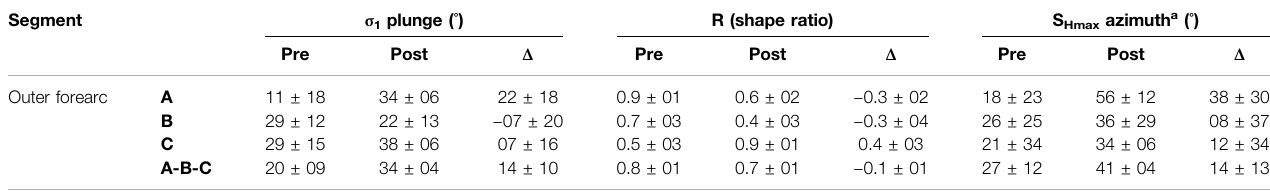
TABLE 2 | Comparison of pre-mainshock and post-mainshock stress inversion results. Angles are in degrees and measured positive clockwise (S Hmax calculated from the stress orientation parameters in Table 1 according to Lund and Townend, 2007). Segment